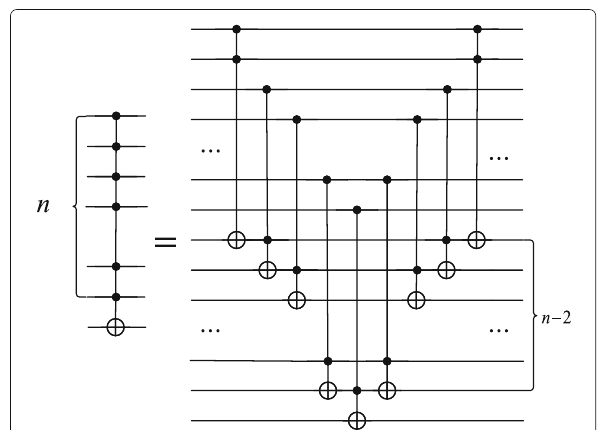
Fig. 5 The decomposition of n -fold controlled-NOT